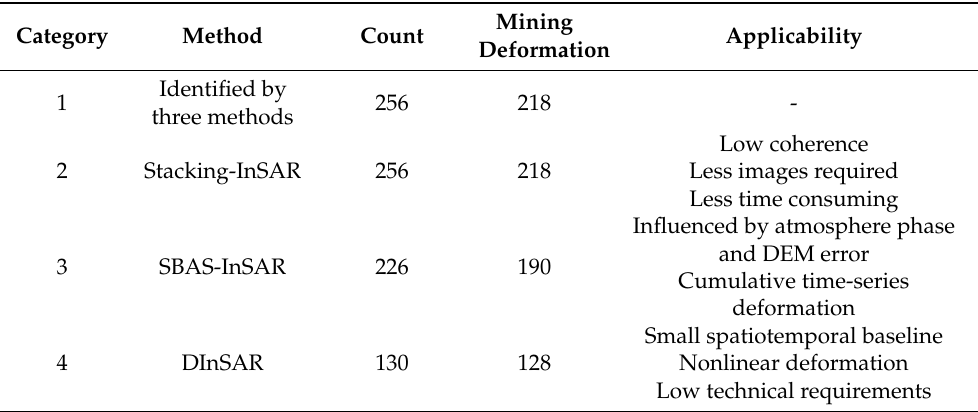
Table 3. Statistical results and applicability analysis of DInSAR, stacking-InSAR and SBAS-InSAR.